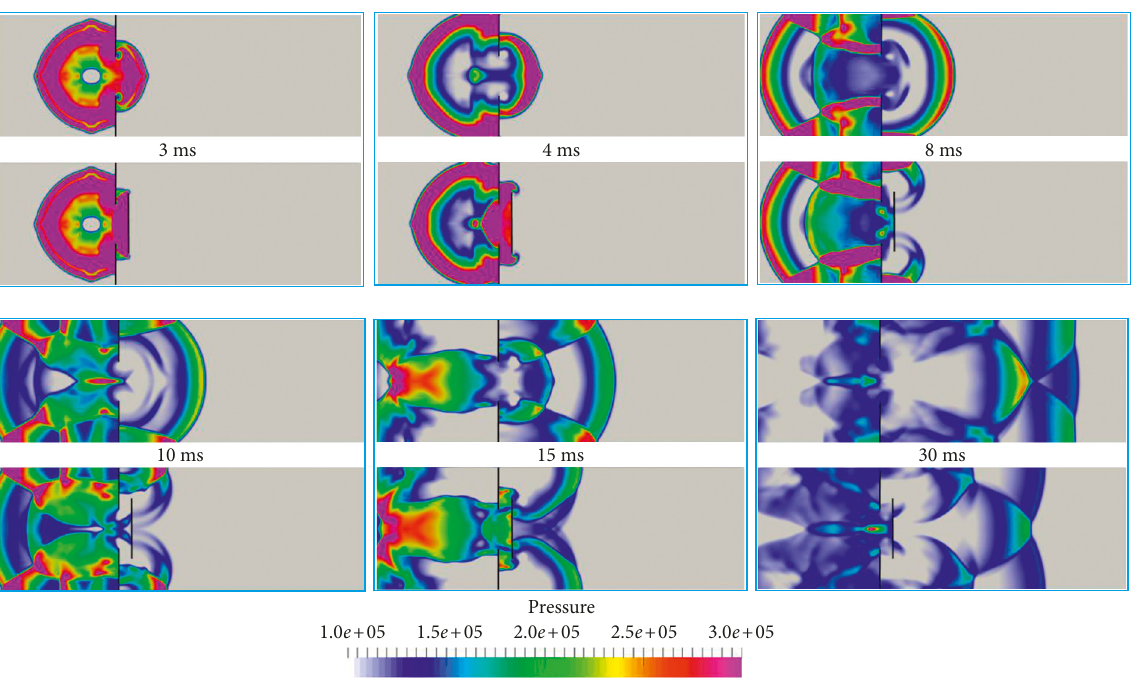
Figure 7: Pressure distribution of the blast wave for the “open door” model and a “meandering” model ( D frames (Pa).